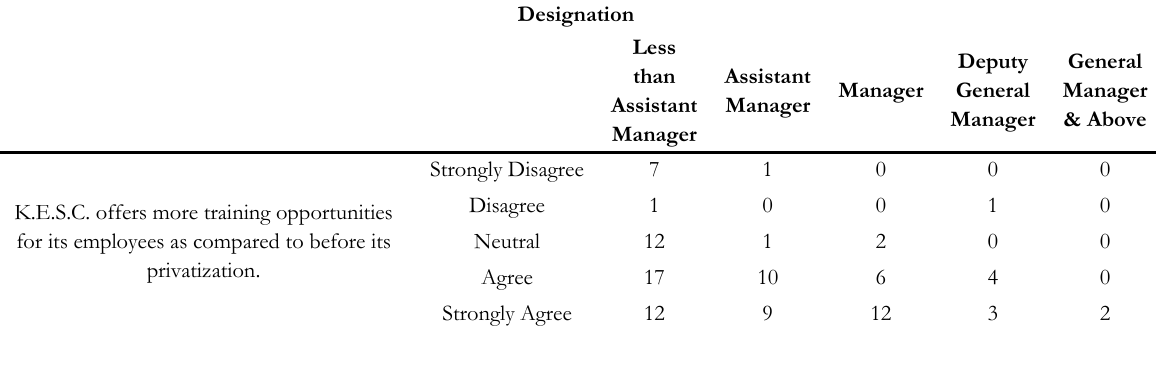
Table 8: Q10 * DSG Cross